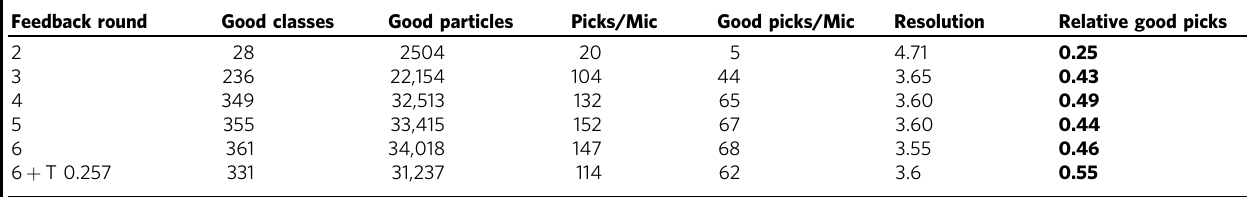
Table 3 Summary of the feedback loop statistics for the TRPC4